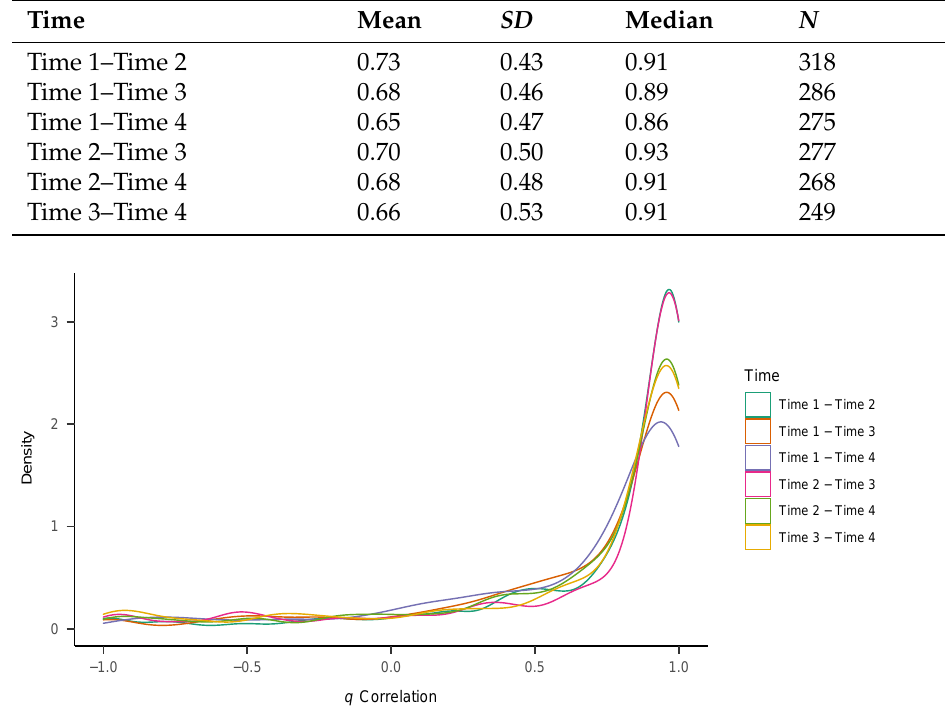
Table 6. Descriptives of q correlations of main diffusion model parameters across time.